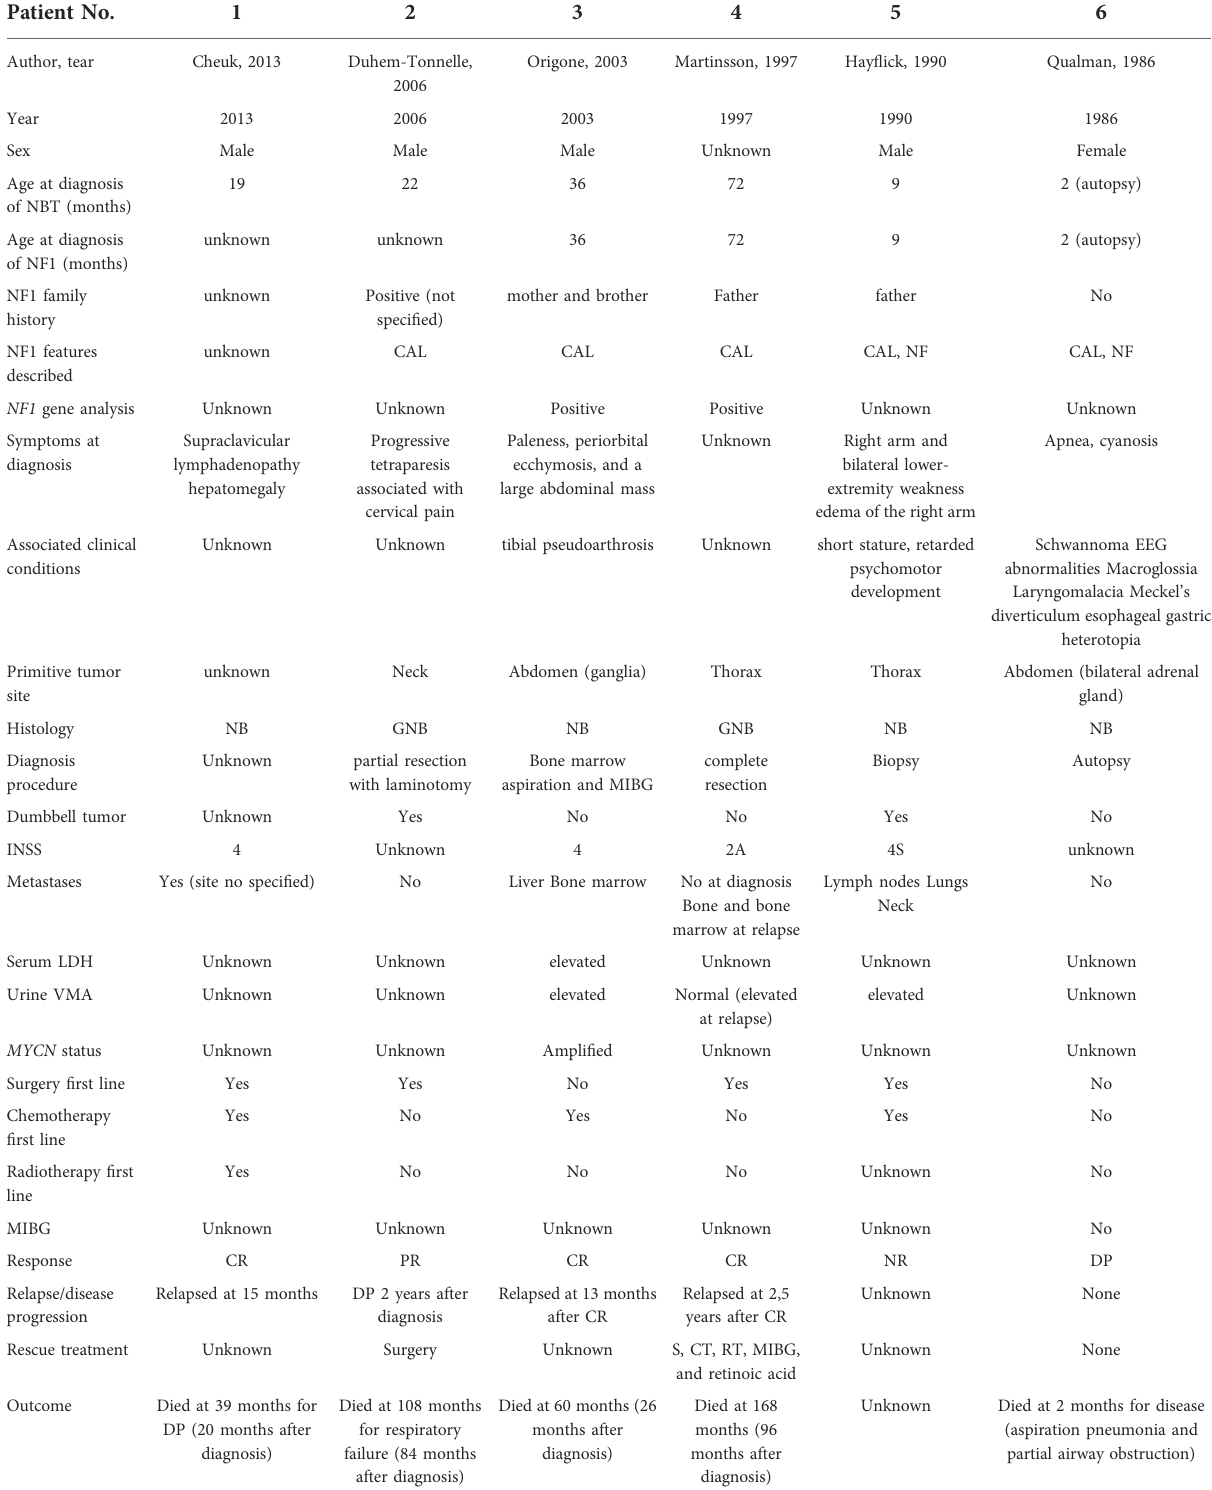
TABLE 6A Description of the cases reports analyzed by the literature (part 1). Patient